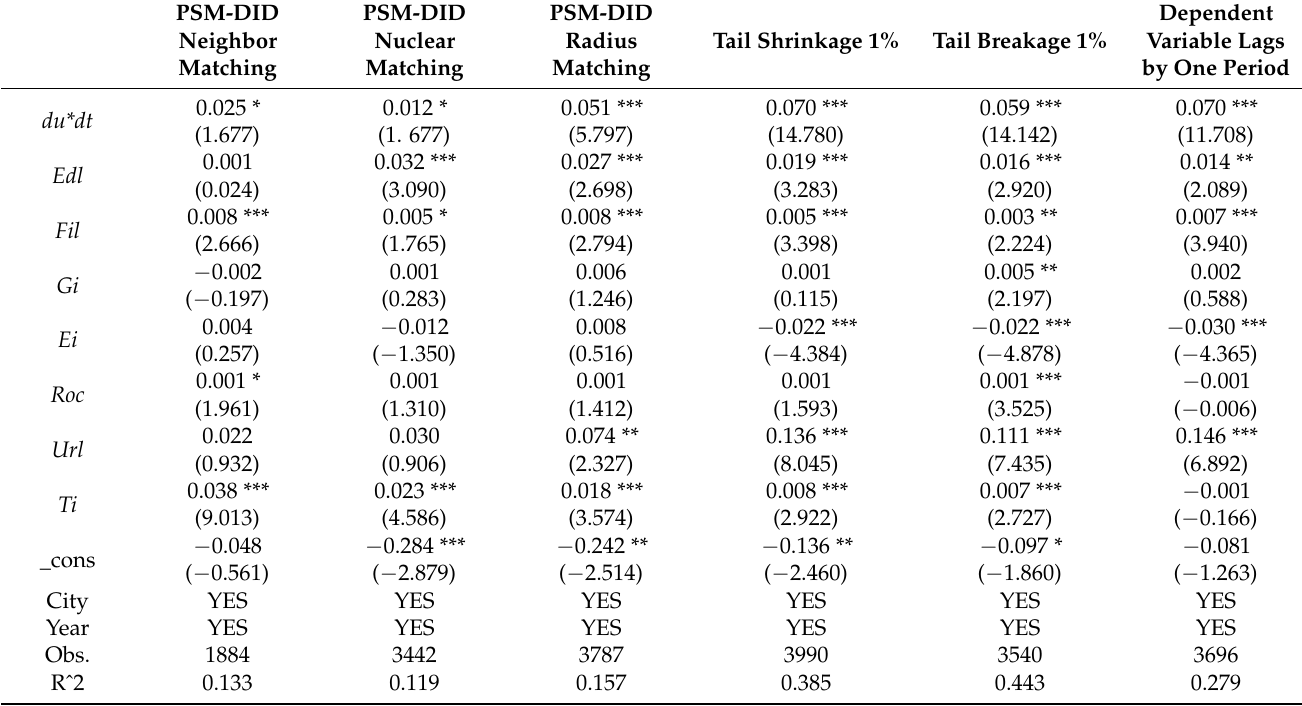
Table 4. Robustness test